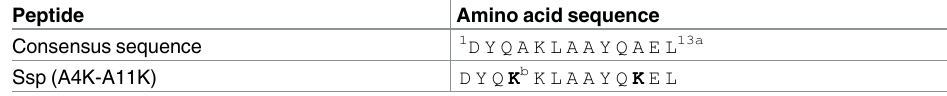
Table 1. Amino acid sequences of SspA/B peptides.